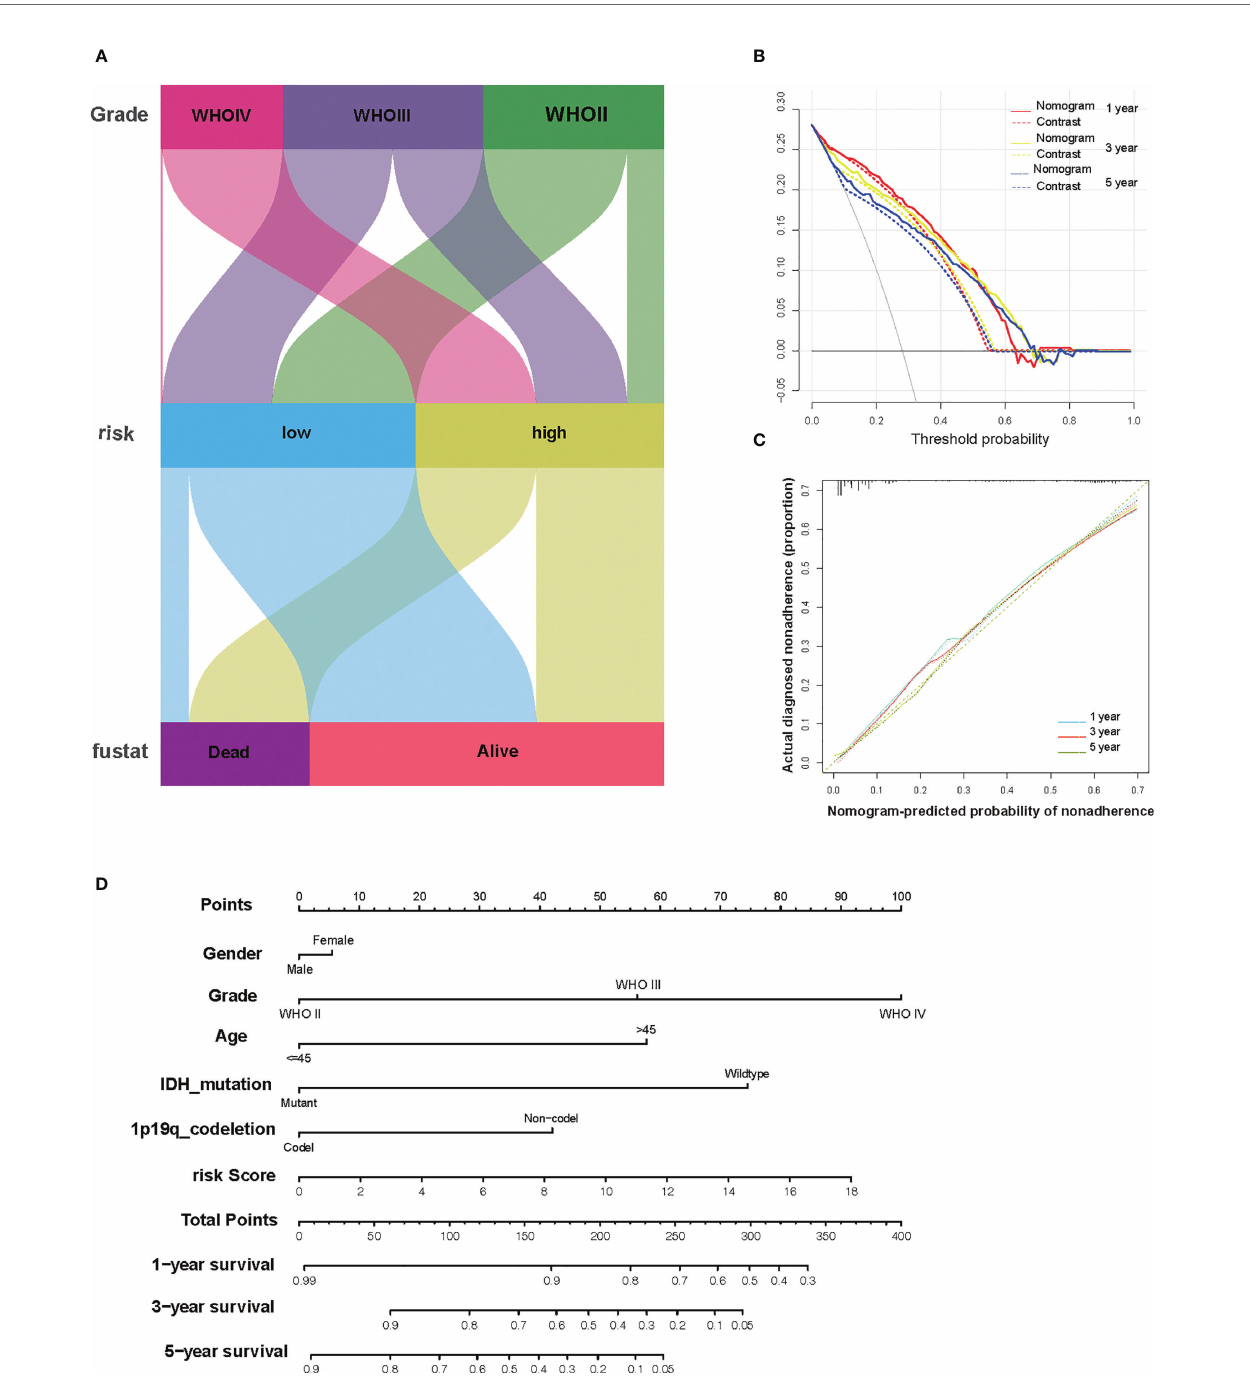
FIGURE 6 | The combination of risk signature and clinicopathological features improves risk strati fi cation and survival prediction. (A) A decision tree was constructed to improve risk strati fi cation. (B) Decision curve analysis of the nomogram and contrast system for predicting the 1-, 3-, and 5-year survival rate of patients. (C) The calibration analysis indicated a high accuracy of survival prediction. (D) A nomogram was constructed to quantify risk assessment for individual